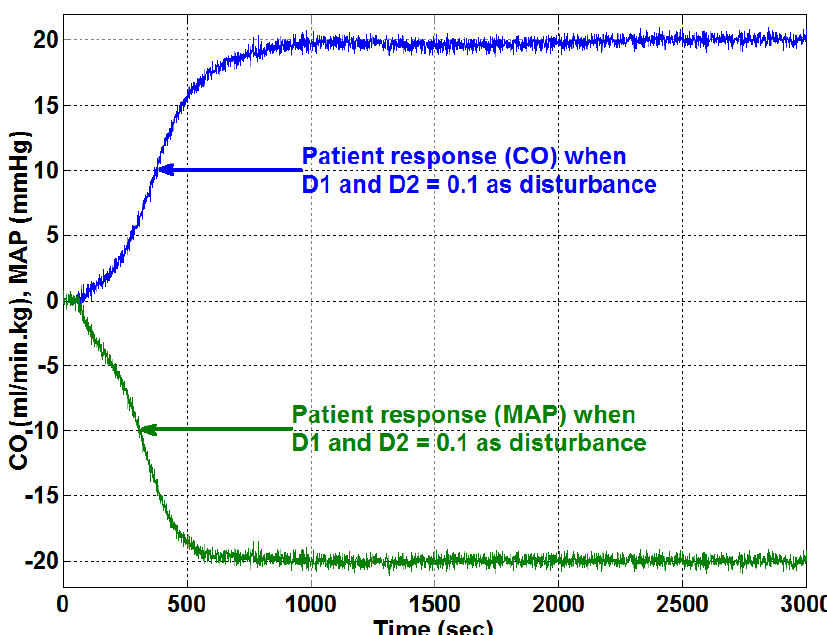
Figure 8: Nominal response with disturbance variance D1=D2=0.1 and set points +20 for CO and -20 for MAP